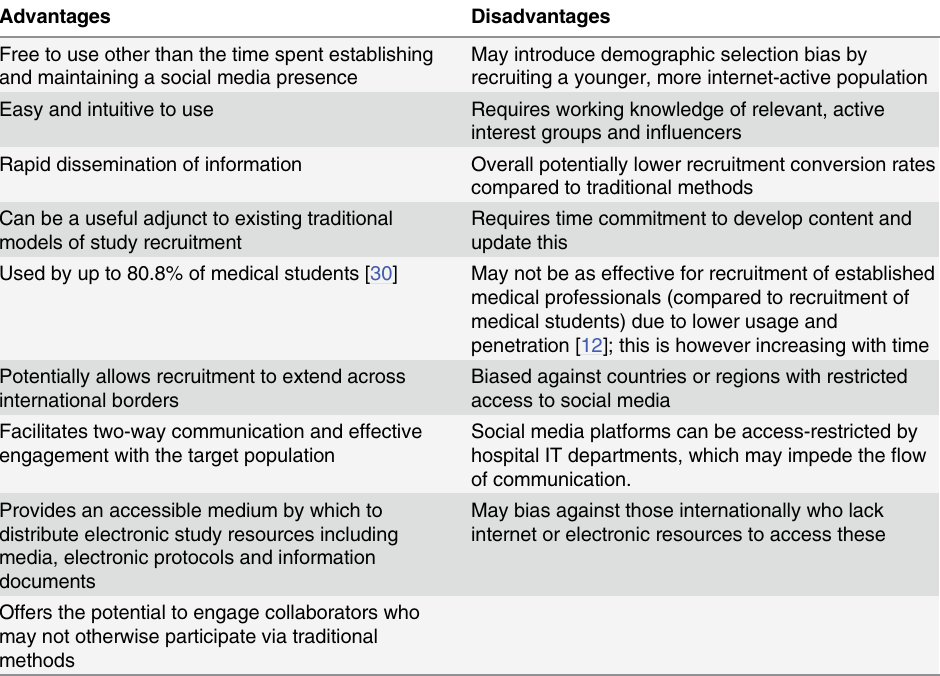
Table 1. Advantages and disadvantages of using targeted social media to aid study recruitment.